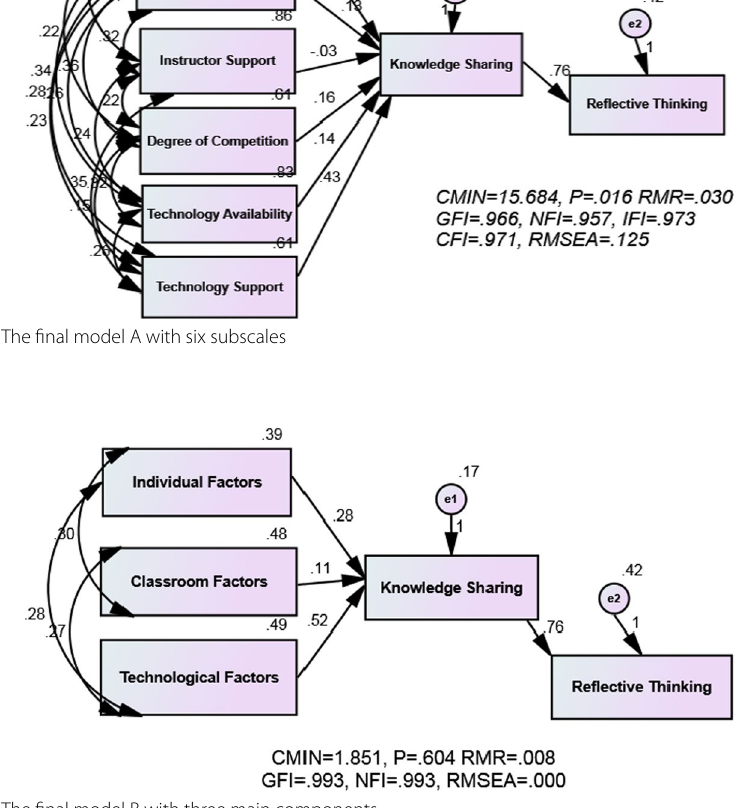
Fig. 3 The final model B with three main components